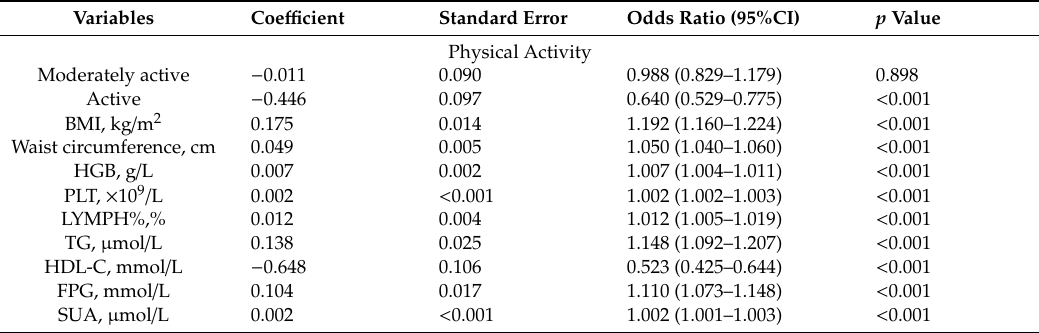
Table 4. Multivariate analysis of risk factors for